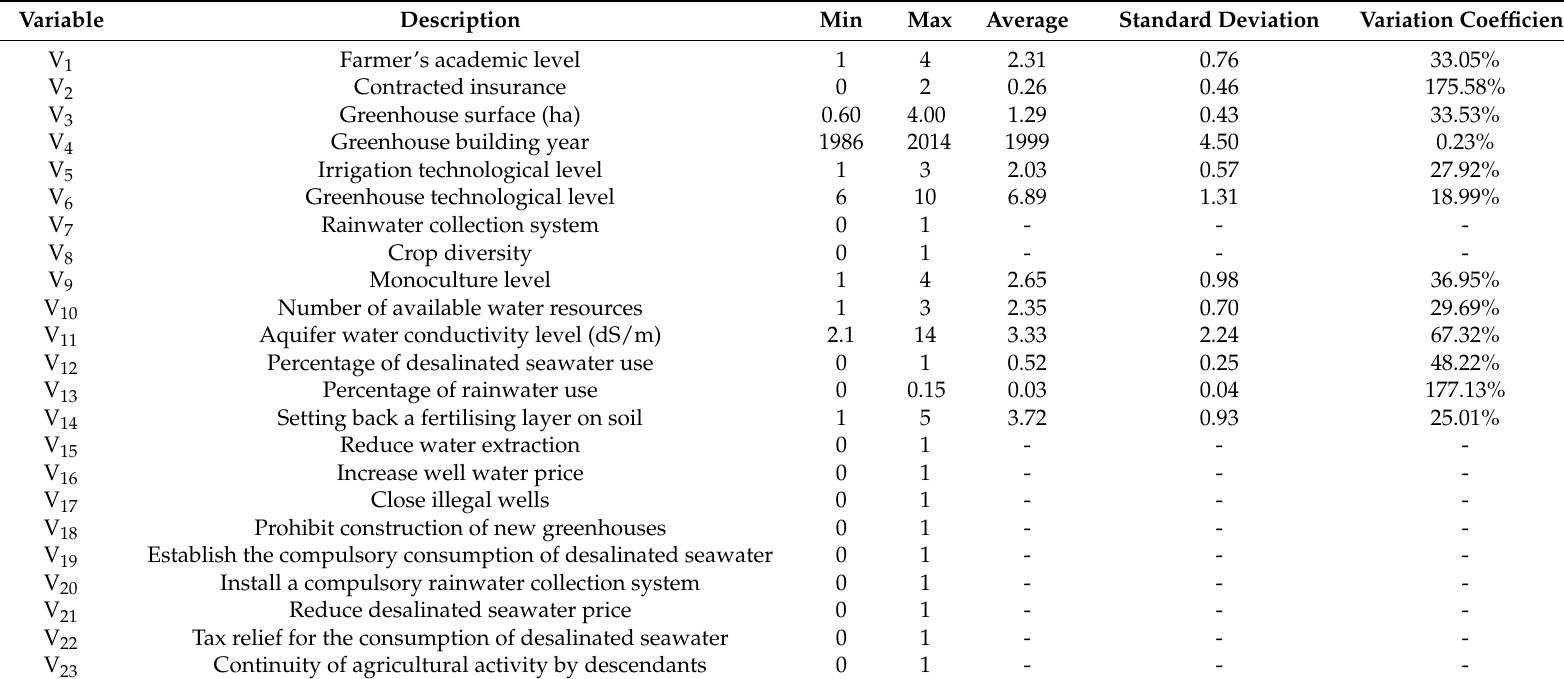
Table 1. Descriptive statistics of the analyzed